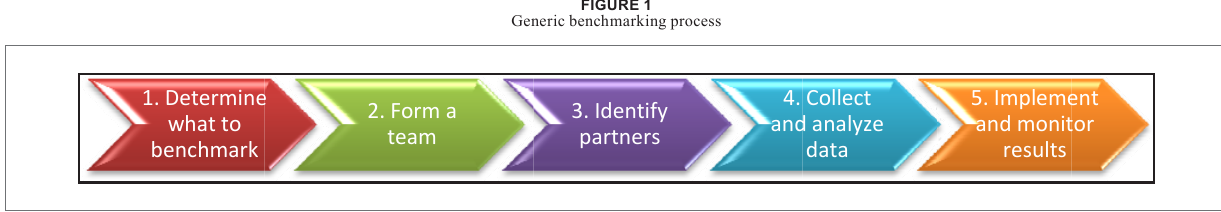
Figure 1 Generic benchmarking